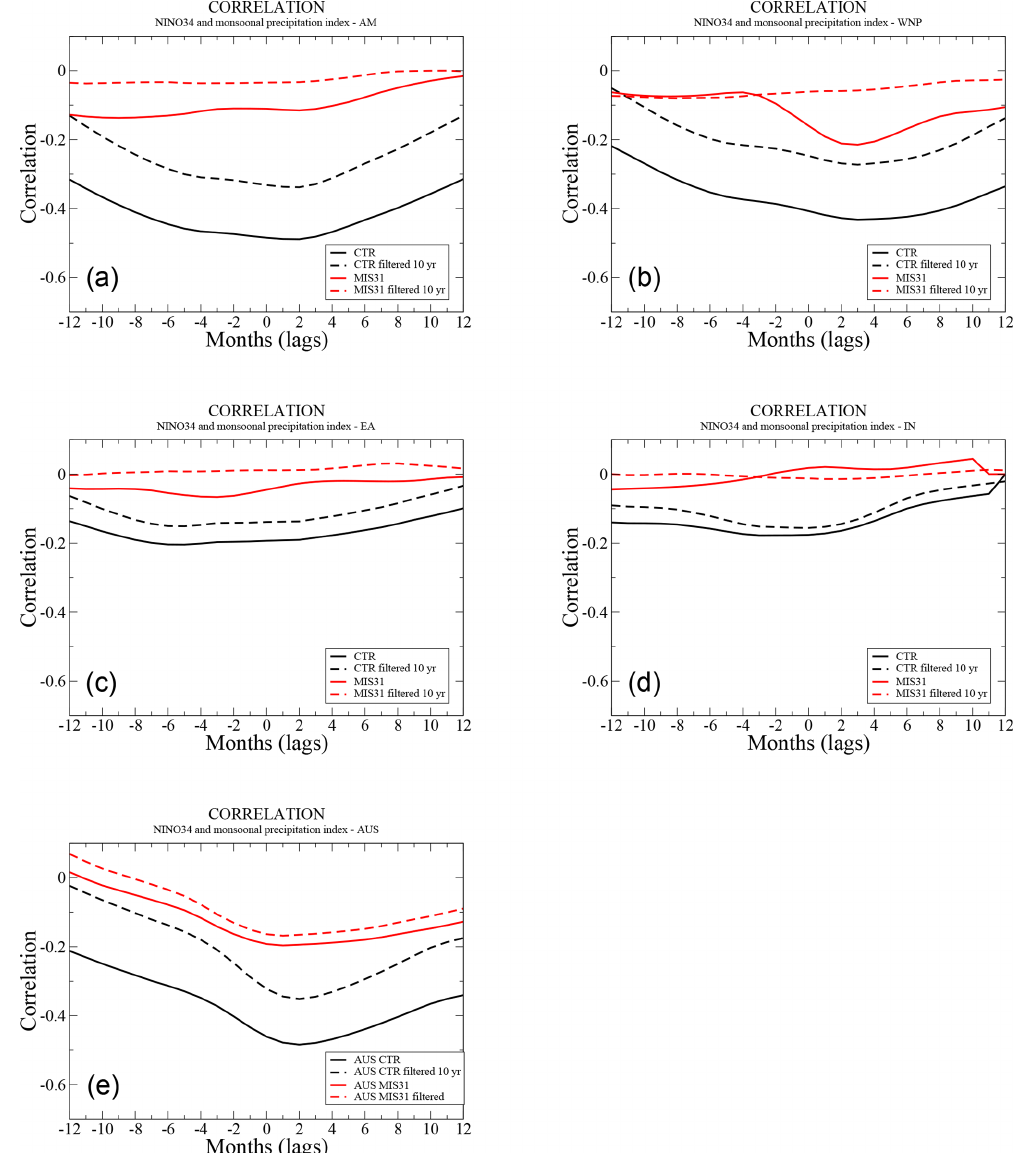
Figure 5. Lag correlations between the Asian and Australia monsoon domains and the NIÑO34 index (black for CTR and red for MIS31 simulations). (a) Asia monsoon, (b) western North Pacific monsoon, (c) East Asia monsoon, (d) Indian monsoon, and (e) Australia